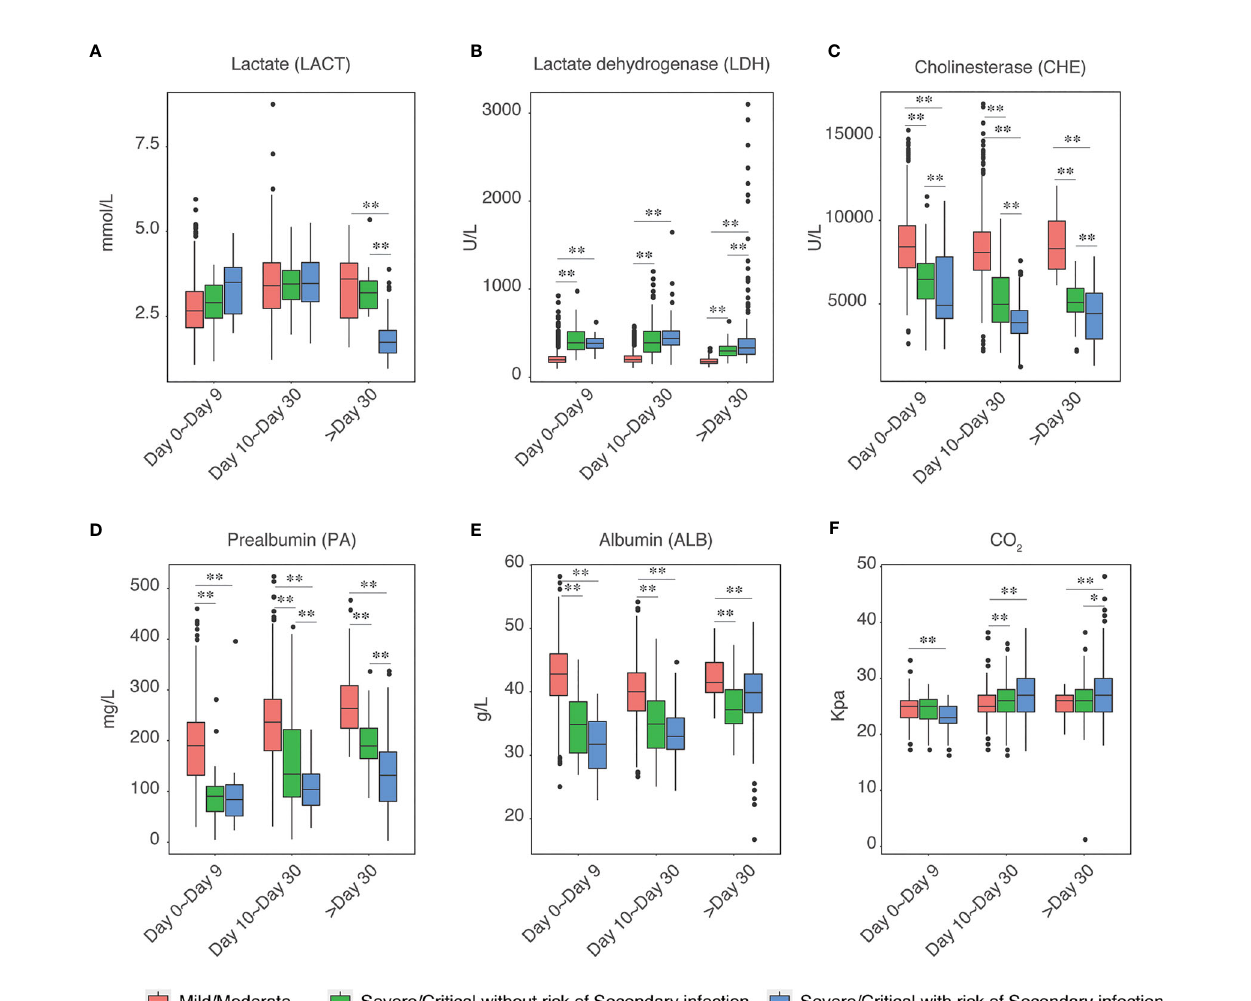
FIGURE 4 | Elevation of Liver injury enhanced the risk of secondary infection. The levels of Lactate (A) , Lactate dehydrogenase (B) , Cholinesterase (C) , Prealbumin (D) , Albumin (E) , and CO 2 (F) in mild/moderate COVID-19, severe/critical COVID-19 without risk of secondary infection and severe/critical COVID-19 with the risk of secondary infection were shown. Each group of samples was further divided into three groups according to the time post-symptoms, including day 0 to day 9, day 10 to day 30, and post day 30. The chosen level of statistically signi fi cance were * P < 0.01 and ** P < 0.05,